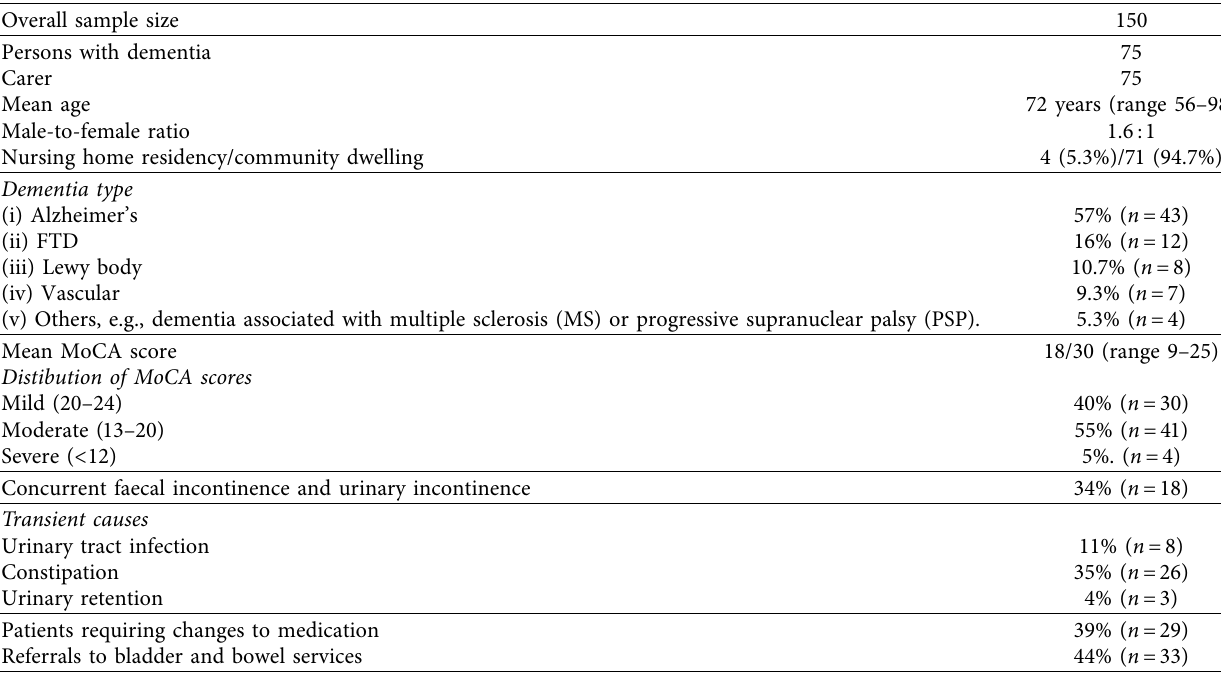
Table 1: Summary of demographics and baseline information.